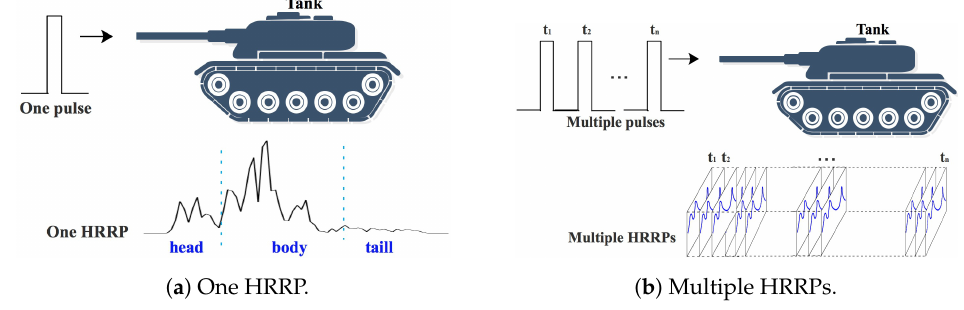
Figure 3. Extraction of the HRRP